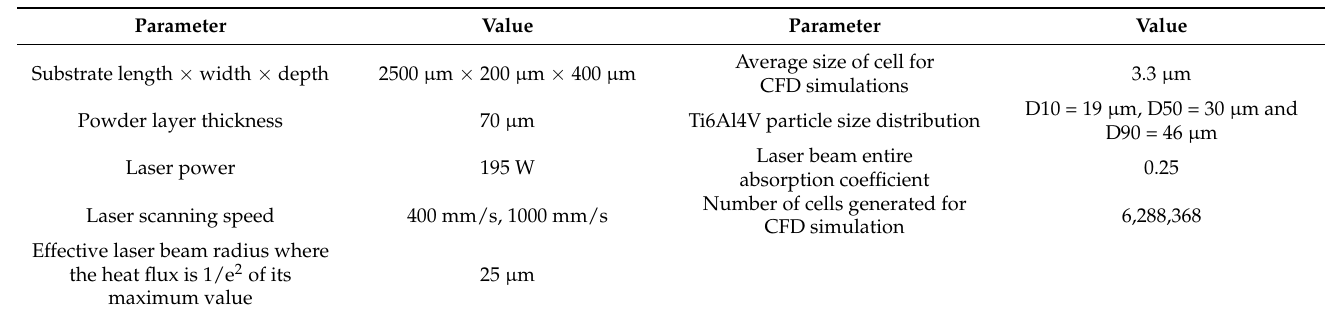
Table 2. Parameters for analytical and CFD simulations